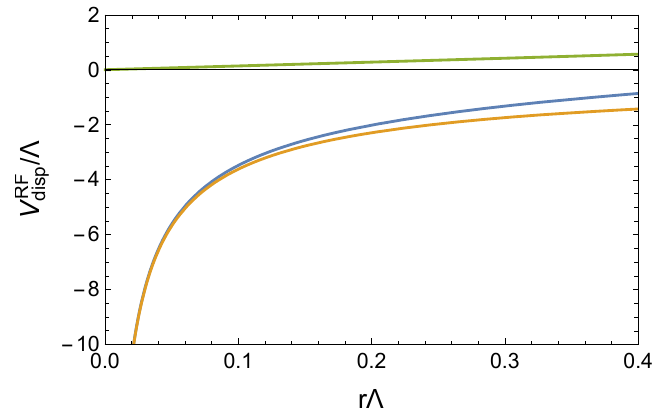
Figure 5 . v RF = ( r (cid:3)) = V RF = (cid:3) as a function of r (cid:3) (blue). Orange line corresponds to the (cid:12)rst disp disp line of eq. (3.16) and green one to the second line of eq. (3.16).